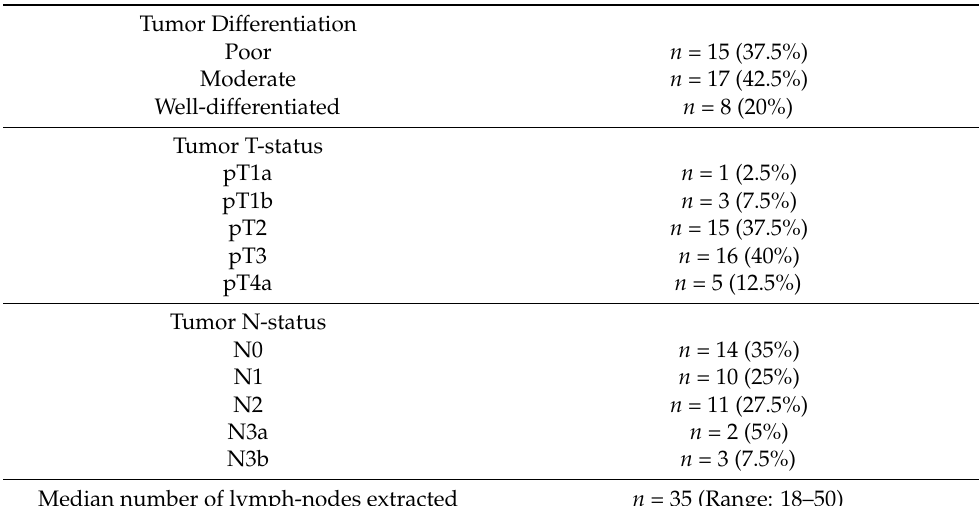
Table 3. Histopathological